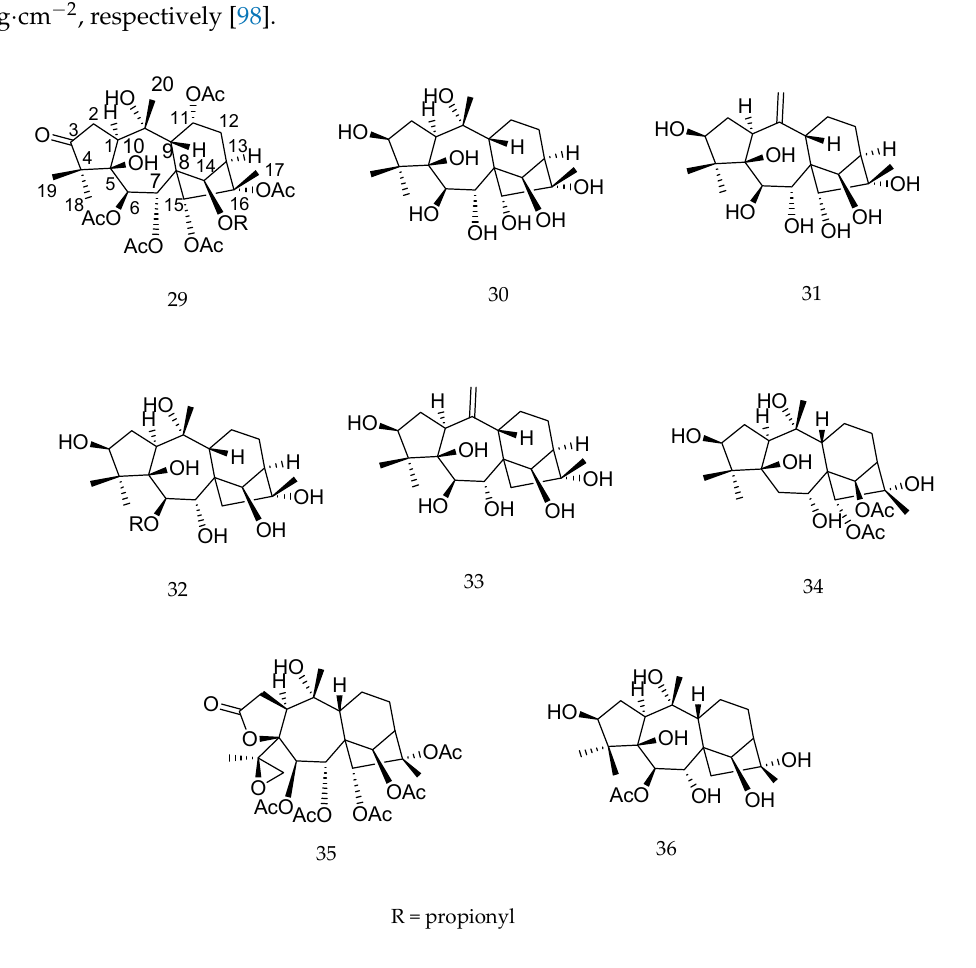
Figure 21. Chemical structures of diterpenes 29 – 36 [98,102].